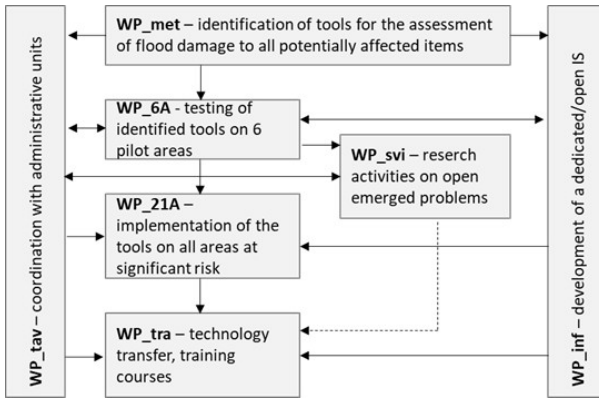
Figure 2. Structure of the MOVIDA